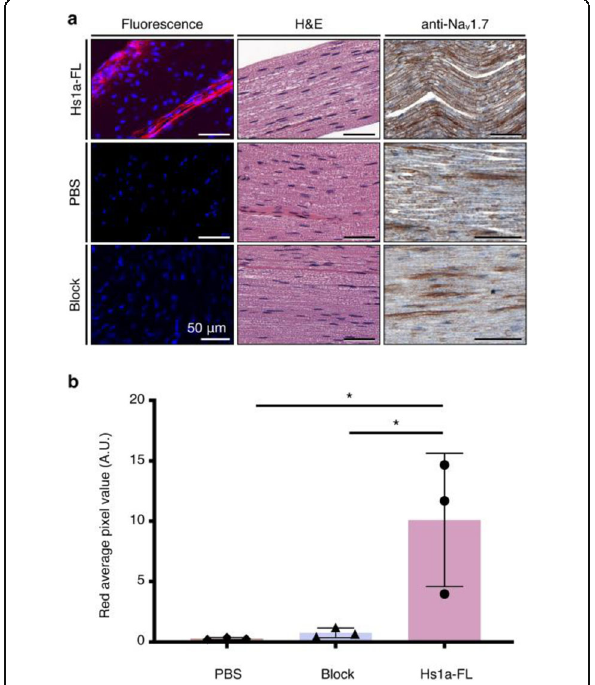
Fig. 3 Ex vivo microscopy imaging of Hs1a-FL in mouse sciatic nerve. a Fluorescence of Hs1a-FL-stained mouse sciatic nerves compared to mice injected with vehicle (PBS) or co-injected with Hs1a (Hs1a-FL, 45 μ M, 4 nmol and Hs1a 120 μ M, 12 nmol in 100 μ L PBS). H&E staining of adjacent nerve tissue and IHC staining, confirming the expression of Na V 1.7. b Quantification of total detected fluorescence. Unpaired t test. * p value <